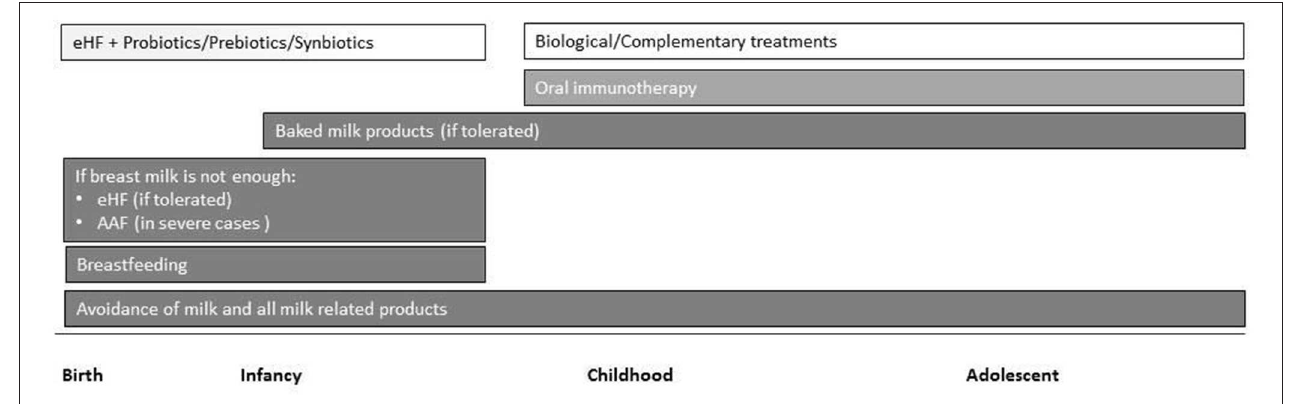
FIGURE 1 | Overview of current and emerging treatment interventions for CMPA in childhood. Intensity of bar color represents the strength of the evidence (eHF, extensively hydrolyzed formula; AAF, amino acid-based